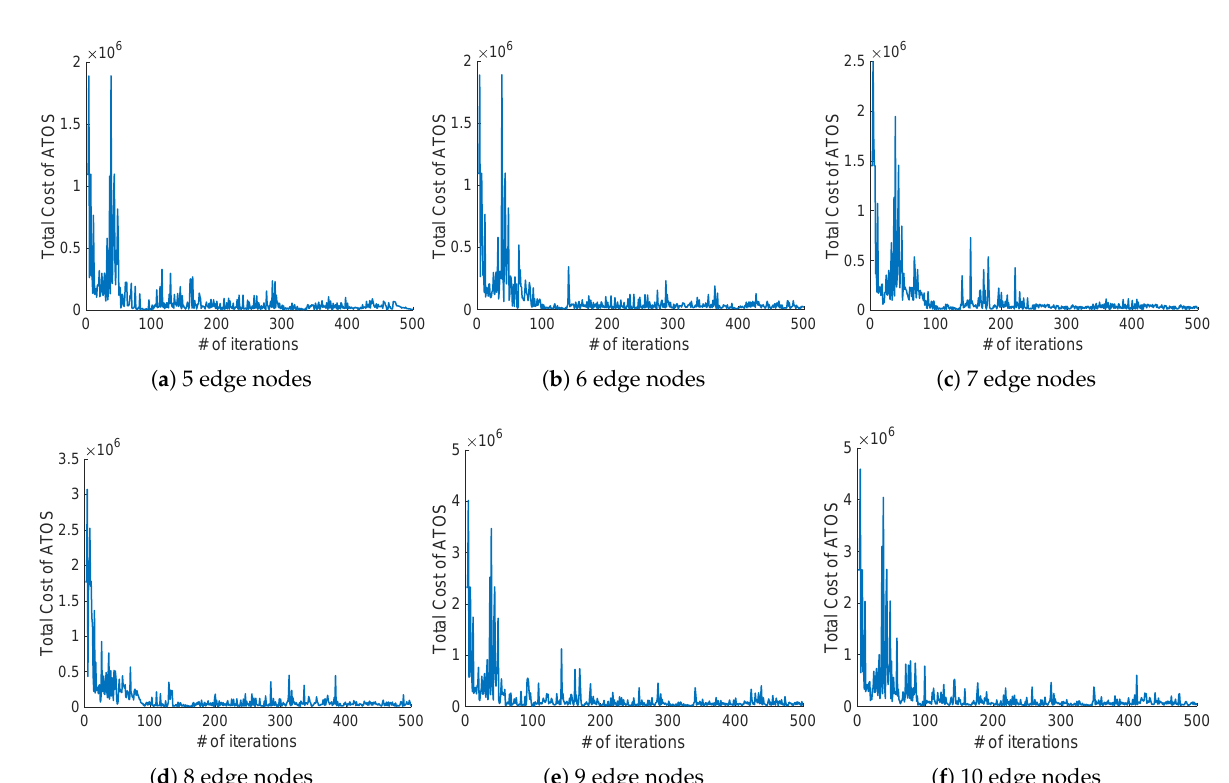
ATOS basically reaches convergence and maintains stability quickly.